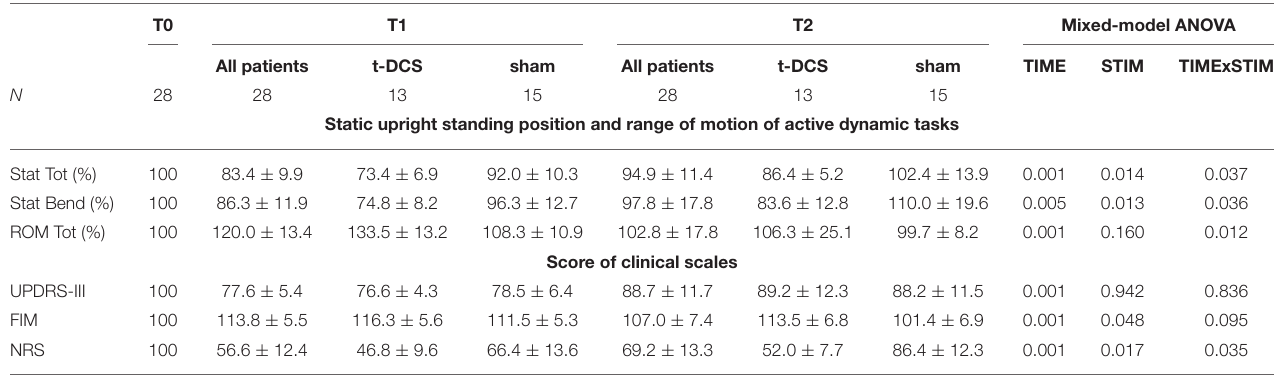
TABLE 2 | Effects of t-DCS and sham treatments on kinematic analysis of trunk parameters and clinical scales. T0 T1 T2 Mixed-model ANOVA All patients t-DCS sham All patients